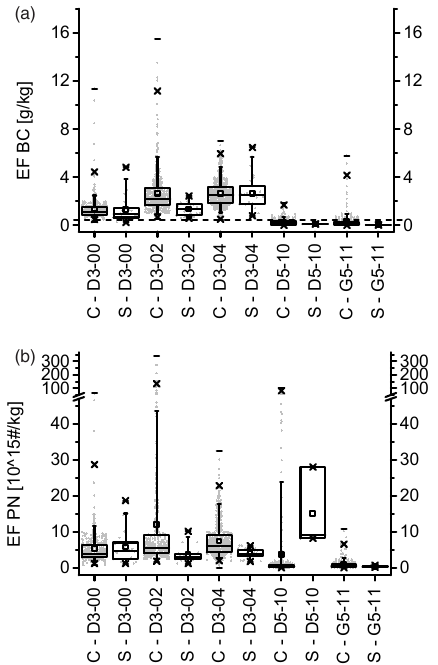
Figure 5. Black carbon (a) and particle number emission factor dis- tributions (b) for each car measured with chasing (C) and station- ary (S) method. Marked values represented are the minimum and maximum (–), 1st and 99th percentile (x), 5th and 95th percentile (whiskers), 25th and 75th percentile (bottom and upper box lines), median (middle box line) and mean ( (cid:3) ) . Grey dots represent the actual data points. The Euro 3 emission standard recalculated from particle mass to BC, assuming consumption of 6L(100km) − 1 and 48% BC content in PM is shown with dashed line in (a) .